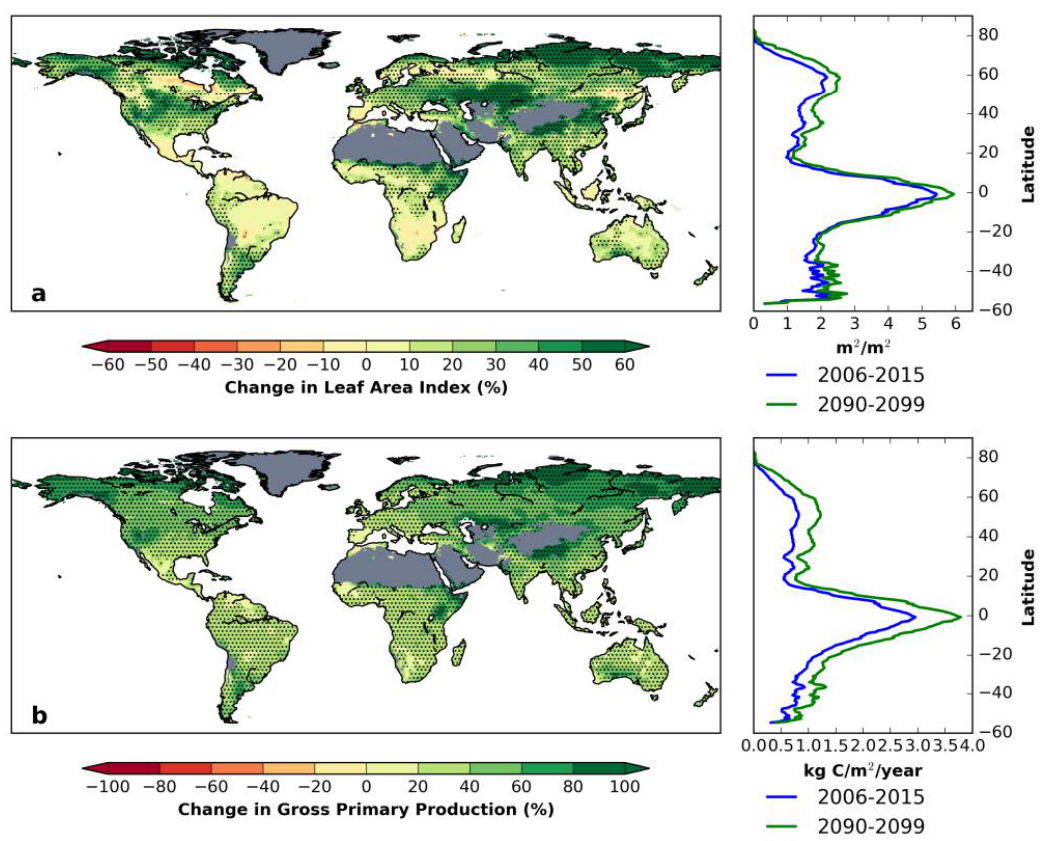
Figure 2. Greening of the Earth. Simulated changes in leaf area index (LAI) and gross primary production (GPP) from the Earth system models of CMIP5. Shown are differences in annual average mean LAI ( a ) and annual total GPP ( b ) at each grid cell for 2090–2099 minus 2006–2015. Stippling shows statistically significant differences among models from a Wilcoxon signed rank test at the 95% level. Right subplots are latitude average of LAI and GPP for 2006–2015 (blue) and 2090–2099 (green).